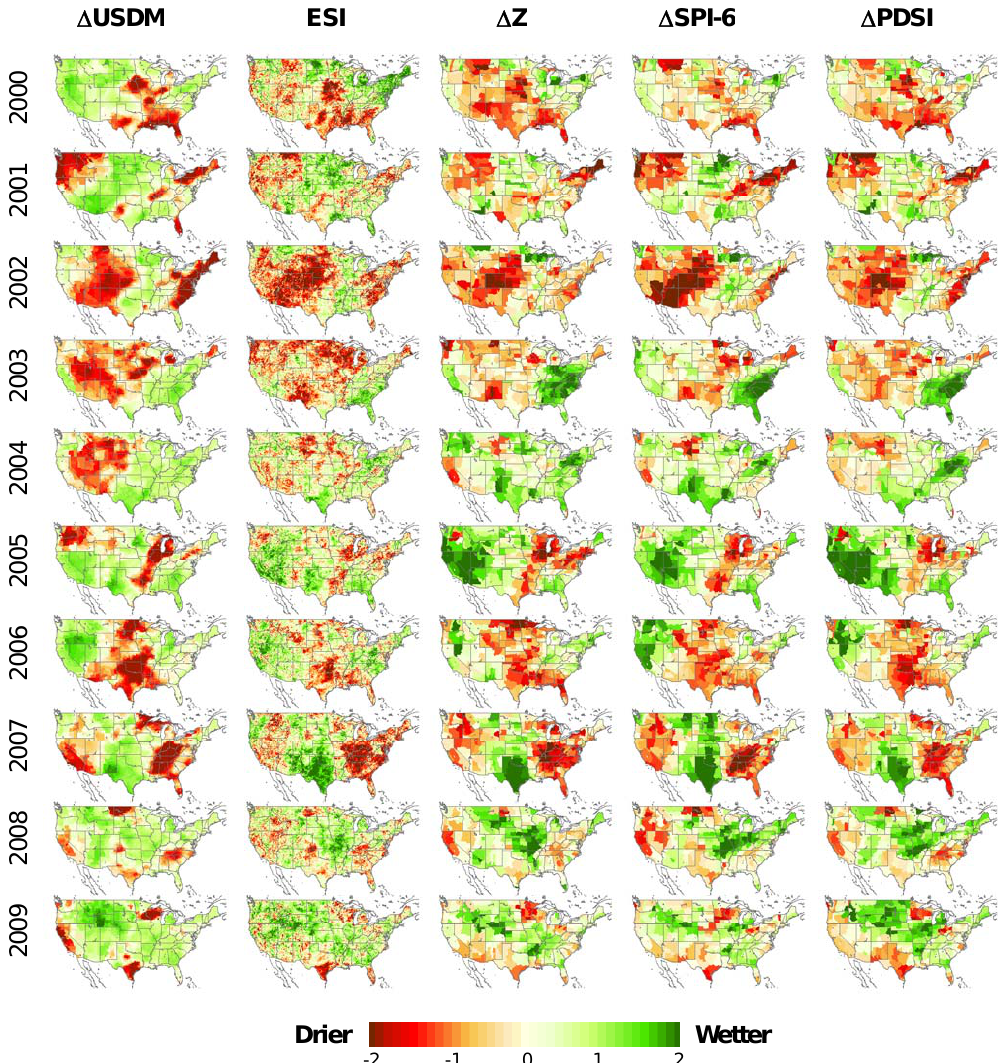
Fig. 5. Seasonal (26-week) anomalies in the USDM, ESI, Z, SPI-6, and PDSI for